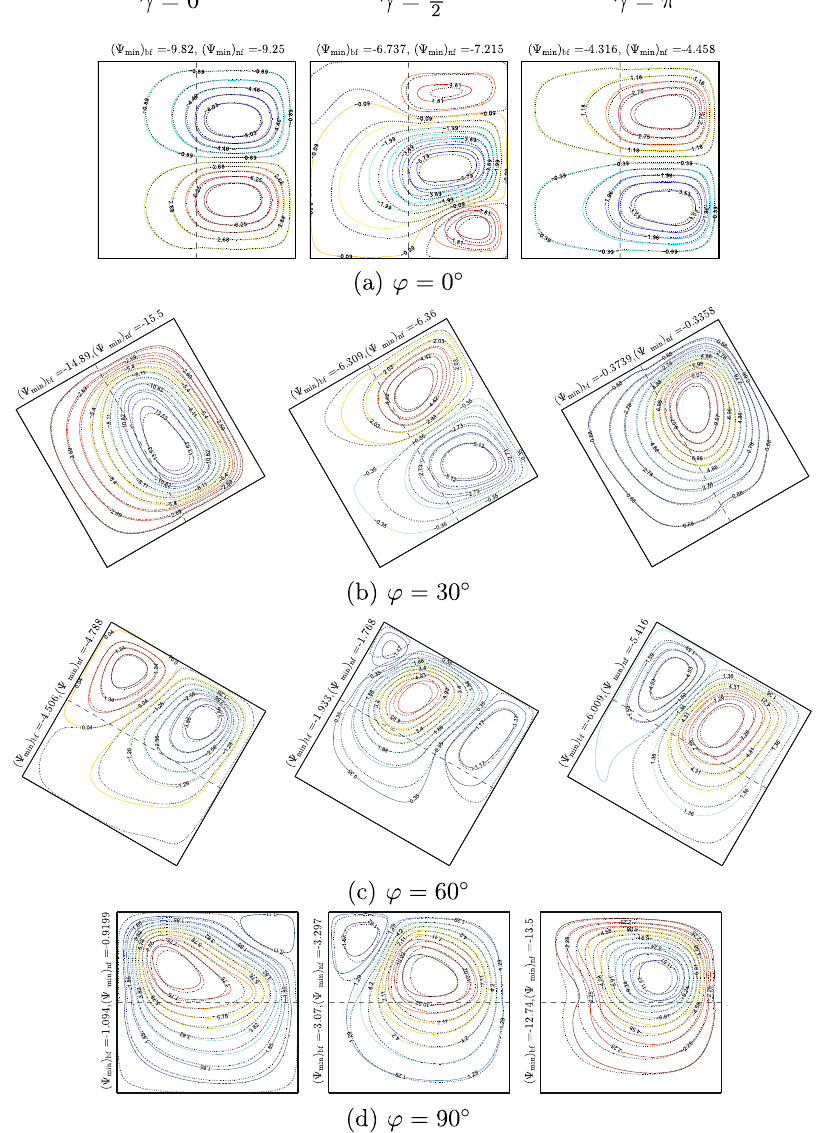
Figure 8. Streamlines evolution by ϕ and γ for Ra bf = 10 5 , Da = 10 − 4 , ε = 1, S = 0.5, φ = 0 (solid lines) and φ = 0.1 (dashed